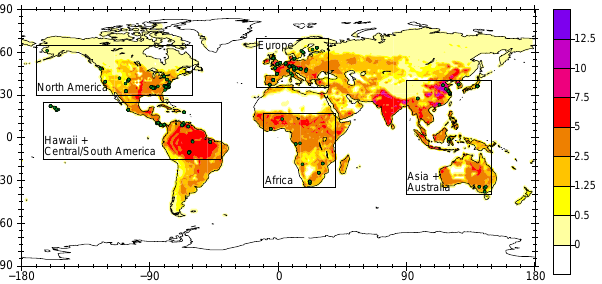
Fig. 1. SNO x flux in the YL95EMAC simulation (in ngm − 2 s − 1 ), along with the locations of measurements (dots) and the regions referred to in Sect. 3.6.1.